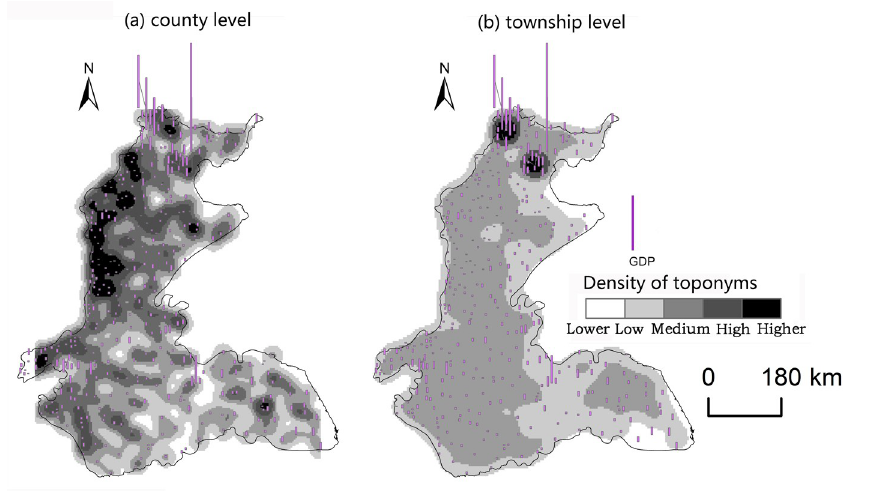
Fig 11. Spatial distribution of toponym density and county GDP of the North China